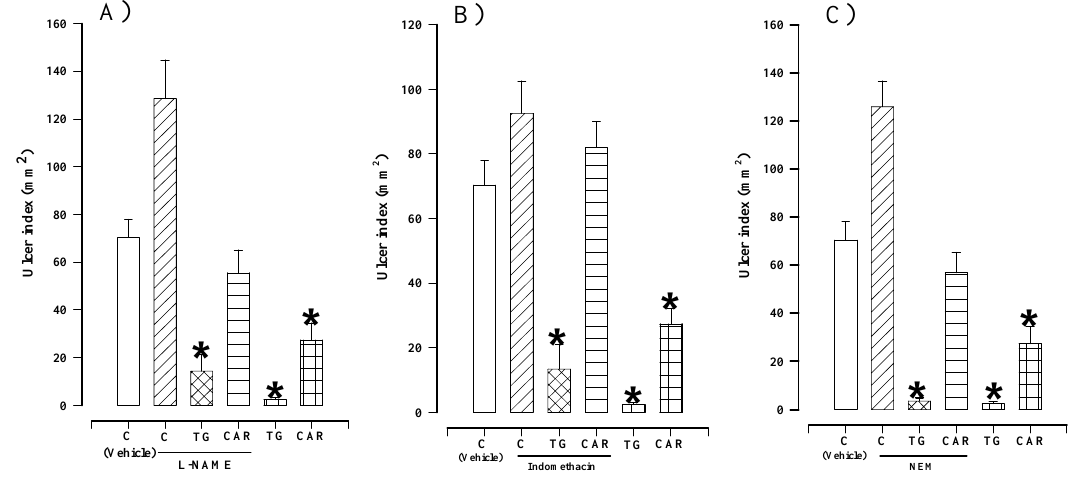
Figure 3. Effect of tagitinin C (TG) and carbenoxolone (CAR) at 30 mg/kg on gastric lesions induced by ethanol in rats pretreated with (A) L-NAME (70 mg/kg), (B) indomethacin (10 mg/kg) or (C) NEM (10 mg/kg). Bars represent the mean ± SEM, n = 10. * p < 0.05 vs. the respective control; Dunn’s multiple comparison test after Kruskal-Wallis